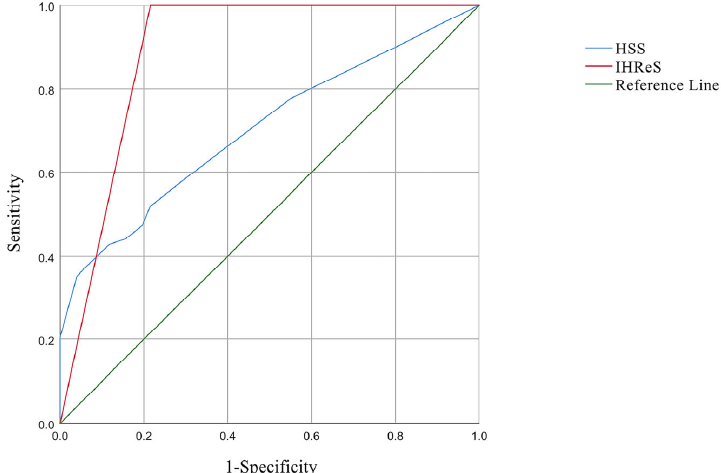
Table 2. Statistical parameters for the studied clinical measures of the HSS and IHReS.